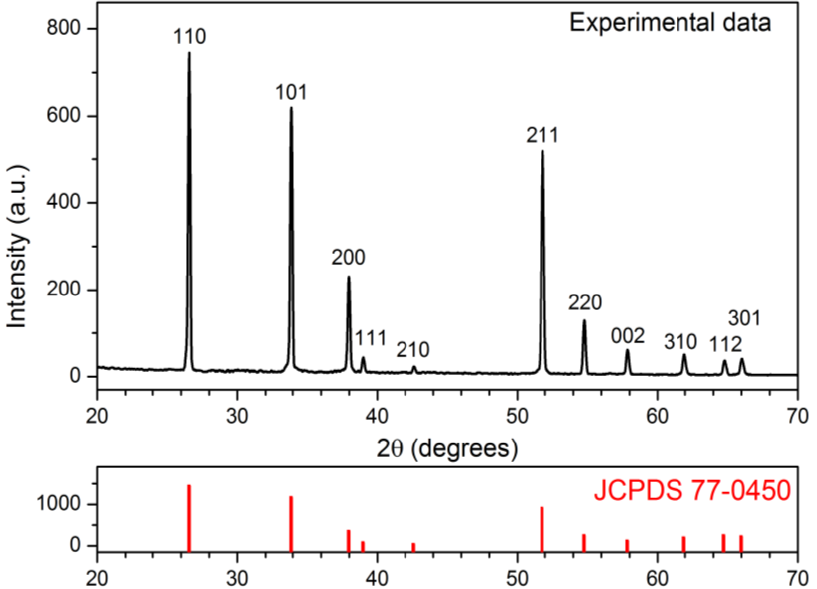
Figure 2. XRD patterns: top (black): experimental pattern of the SnO 2 nanowires used to fabricate the single-nanowire sensor; bottom (red online): reference pattern of tetragonal SnO 2 (JCPDS 77-0450).